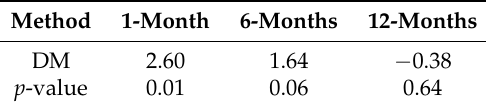
Table 3. Diebold–Mariano Test